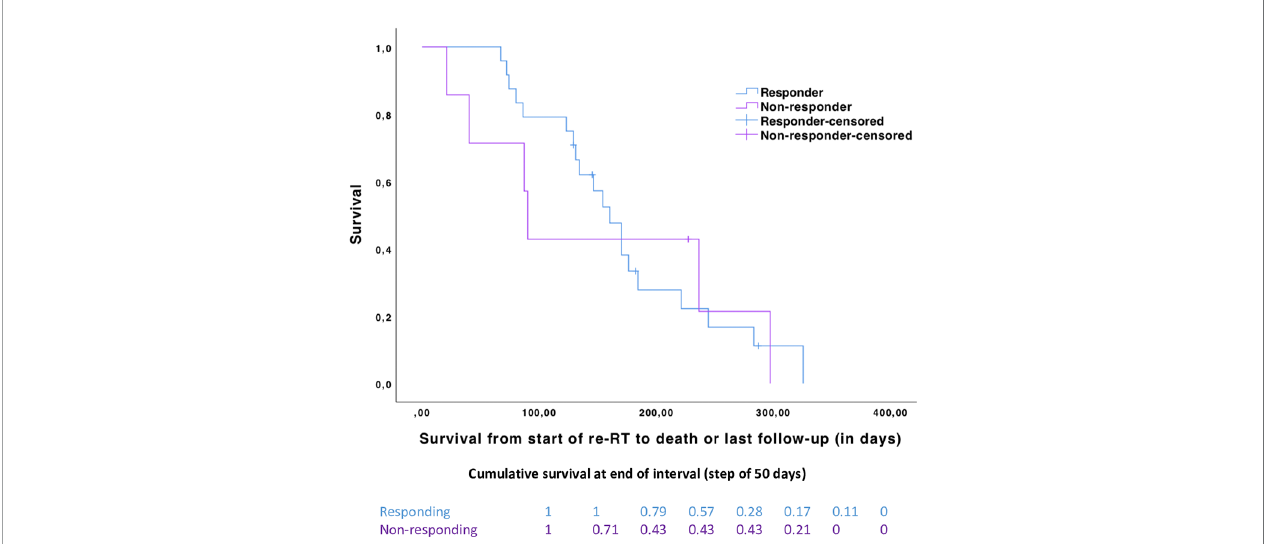
FIGURE 3 | Kaplan – Meier curves with survival from the start of second-line treatment for responding ( n = 24, in blue) and non-responding ( n = 7, in purple) patients (log-rank test, p -value = 0.871). Cumulative proportion surviving at the end of the interval by a step of 50 days between the two groups.